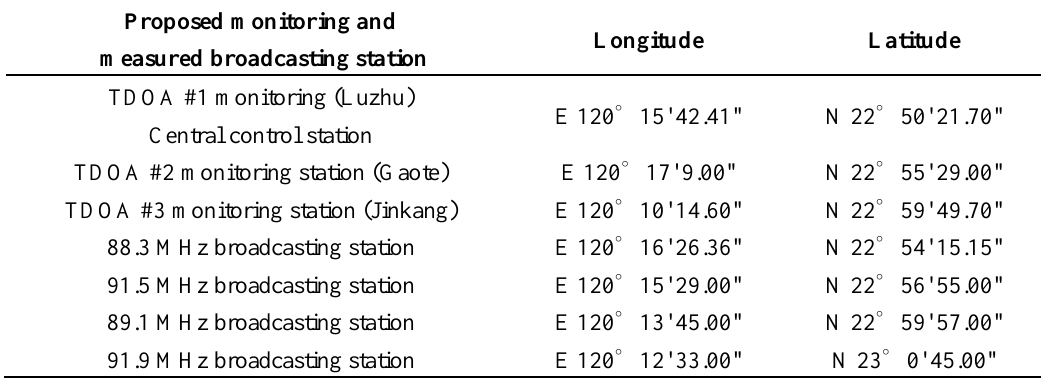
Table 1. The proposed monitoring and transmission position of the proposed